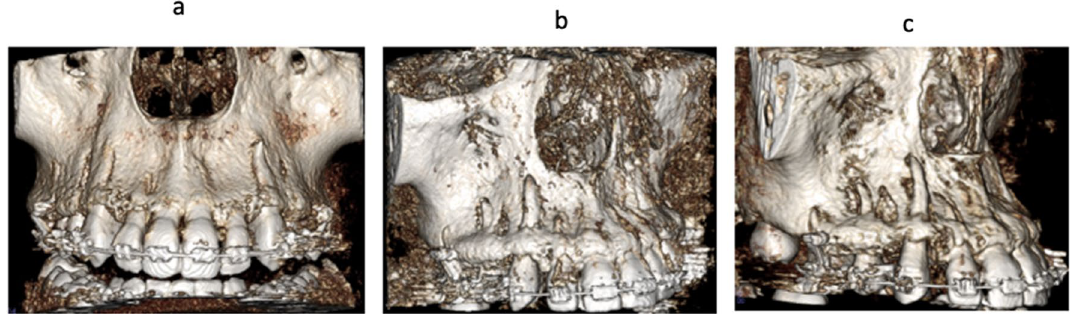
Figure 8. CBCT volumes examined in the 3D solid bone Fig. 2a–c, showed a clear discrepancy between grade C versus grades A or B. The investigated canine roots in grade C (78.6%) were more dominant than the other two grades. Unexpectedly, the percentage of canine roots and apices that belong to category A and B represented only 5.4% and 16.1% of the total sample respectively (Fig. 2d). Analyzing this data from a clinical point of view, almost 95% (Grades B + C collectively) of the total canine roots and apices had intimate relation to the overlying cortical bone (Table 3). The anatomical nature of the cortical bone, being a thick dense cortical lamellar nature with minimal vascu- larity and reduced remodeling capabilities 62 is its own advocate as a mean to halt the movement of the canine root apex. This nature of the cortical bone was implemented in the Tweed treatment philosophy that used to torque the dental roots towards the overlying cortical bone as a mean of anchorage reinforcement 5 . The findings of slow OTM, severe tipping of the canines, negligible movement of the canine roots and root apices together with the relation of the canine to the overlying dense avascular minimally remodeling cortical bone is interesting. Curiously, comparing the pre-retraction to the post-retraction data for the same patients (Table 4), there is a pattern of deterioration of the grade of the Root/Cortical bone Relation towards a situation of more engage- ment to the overlying cortical bone. As shown in Table 4, out of the five roots and apices that belong to category A in the pre-retraction position, four of these same canines deteriorated into category C in the post-retraction situation (Fig. 6a,b). And 11 out of the 19 grade B canines in the pre-retraction position deteriorated to category C post-retraction (Fig. 6c–f). Almost all the canine roots and apices which started in category C continued in category C (Fig. 6g–j).